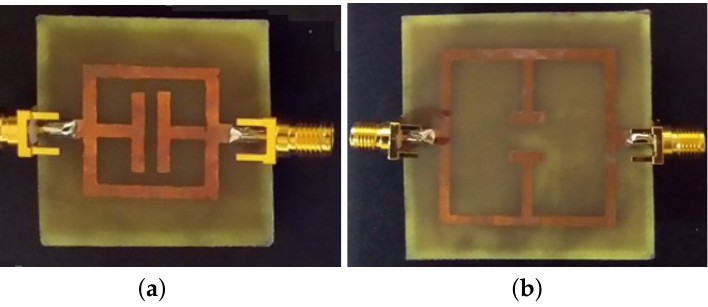
Figure 14. Photos of the prototypes with T-shaped stubs ( a ) parallel and ( b ) perpendicular to the microstrip feeding line.